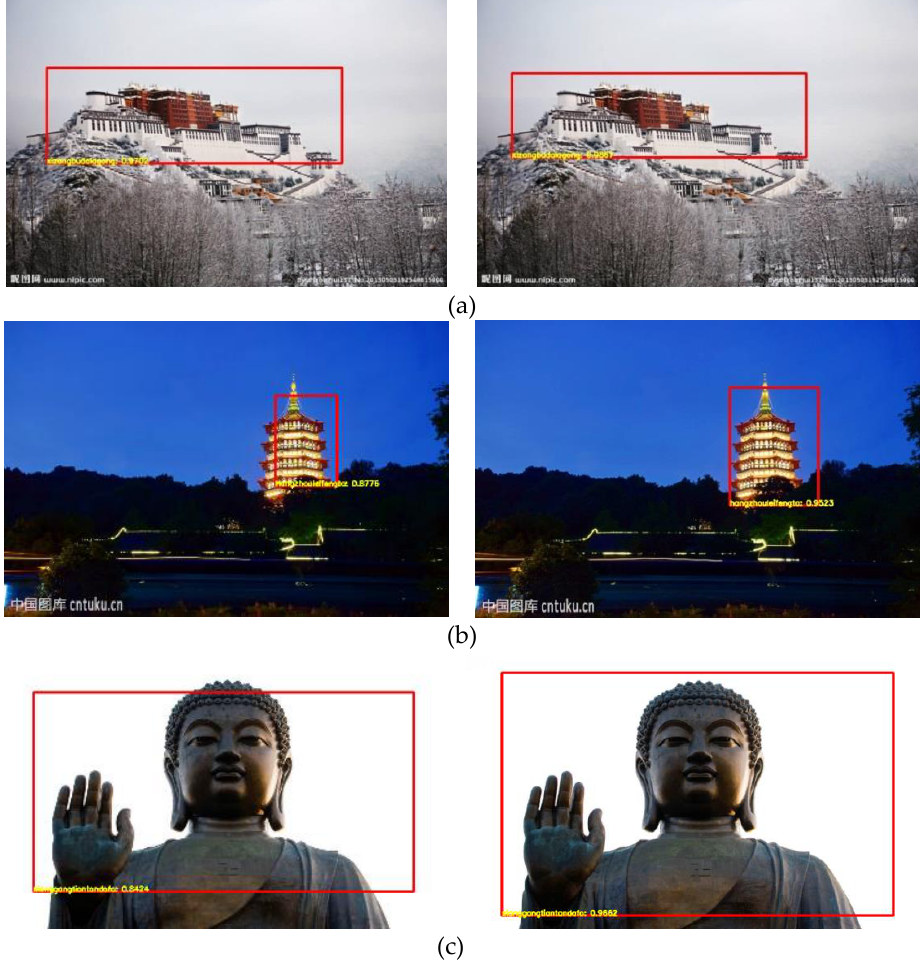
Figure 9. Experiment results of the test images. ( a ) Potala Palace in Lhasa. ( b ) Leifeng Pagoda in Hangzhou. ( c ) Giant Buddha at the temple of heaven in Hong Kong.